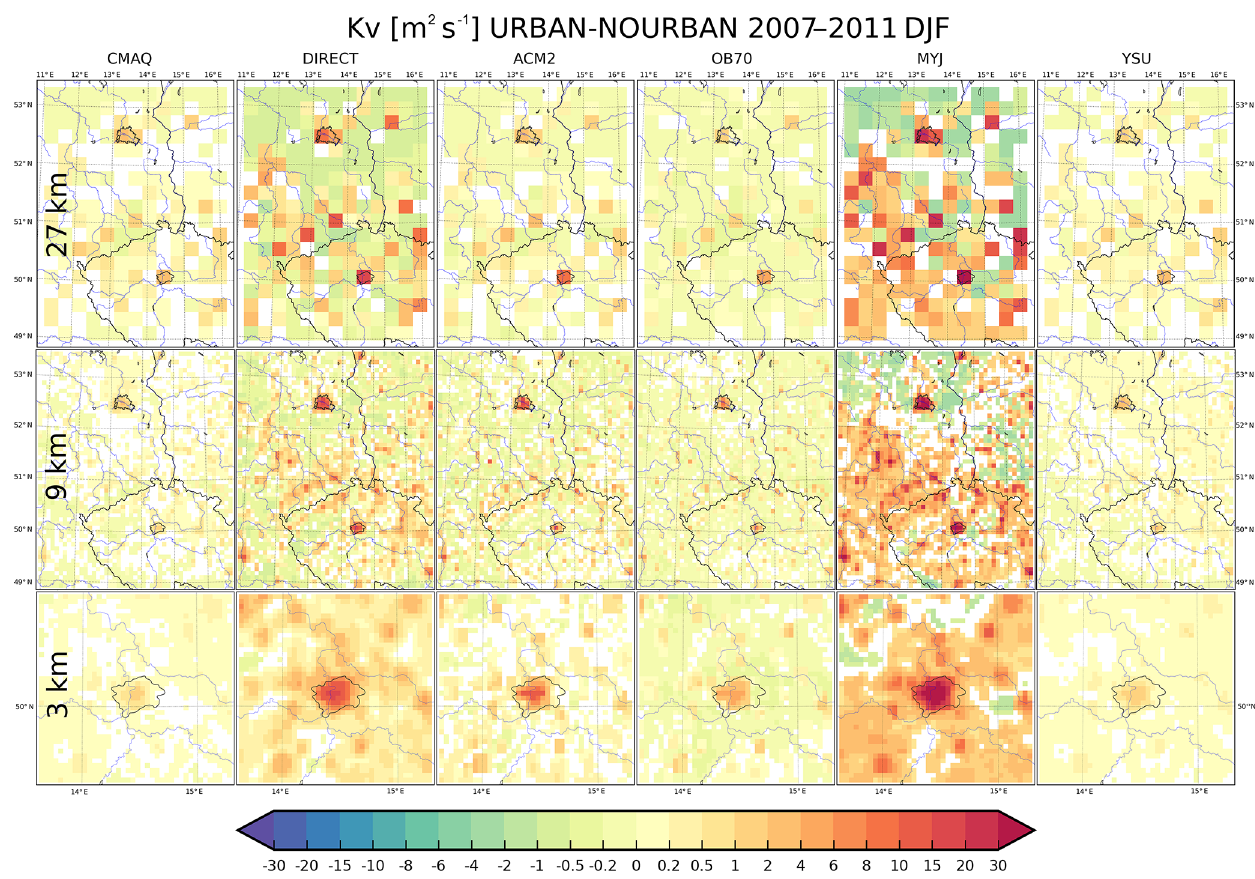
Figure 14. Same as Fig. 13 but for